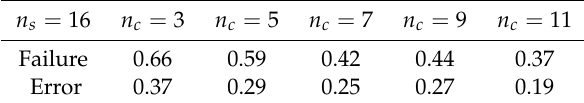
Table 3. Failure rate and error rate (16 shops).